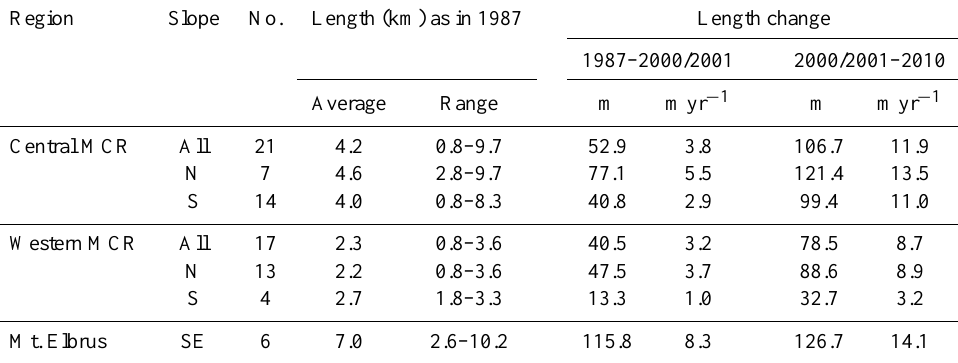
Table 5. Characteristics of glaciers used for measuring snout retreat. The average error terms are ± 9.9 and ± 11m for the 1987–2000/2001 and 2000/2001–2010 periods